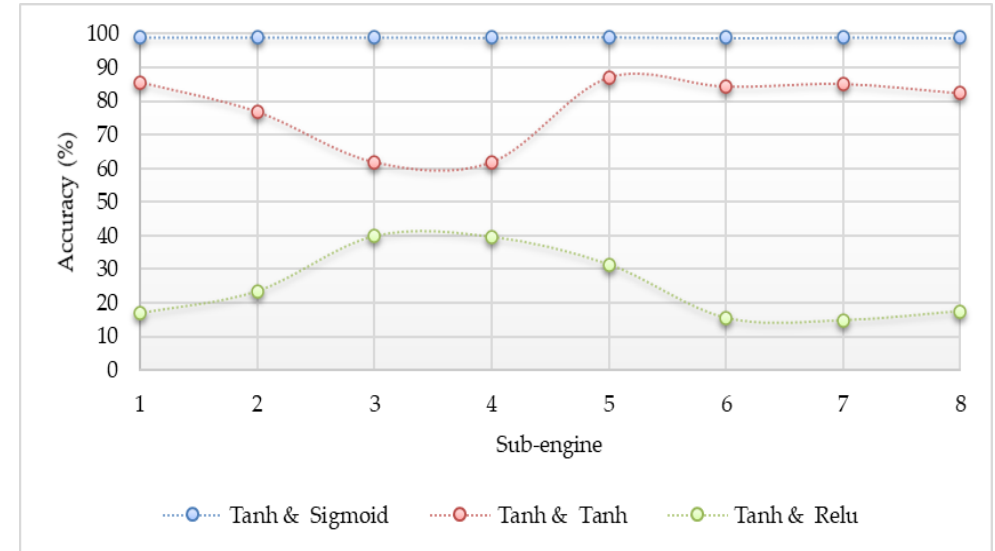
Figure 4. Accuracy comparison for detecting IoT botnets attacks by a simple neural network (tanh in the hidden layer and different functions in the output layer).